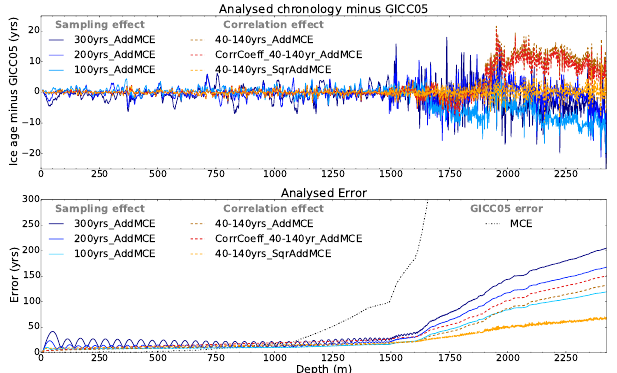
Figure 5. Sensitivity of the age solution to sampling of duration constraints. The simulations settings are as follows: (i) three differ- ent uniform sampling rates (dark to light-blue lines: 300, 200 and 100 years) and (ii) one adaptive rate ranging from 40 to 140 years (dashed coloured lines). The marker errors are derived under the AddMCE assumption (full correlation between annual cycles), ex- cept for (i) simulation 40–140yr_SqrAddMCE, which is run under the SqrAddMCE assumption (correlation cut-off above 20 years), and (ii) simulation CorrCoeff_40–140yr_SqrAddMCE, which is run with a finite depth range correlation coefficient. The curves represent the difference between the different analysed and back- ground chronologies. The difference between GICC05 and back- ground chronologies is displayed for comparison (dashed black line). Table 1 summarizes experiment